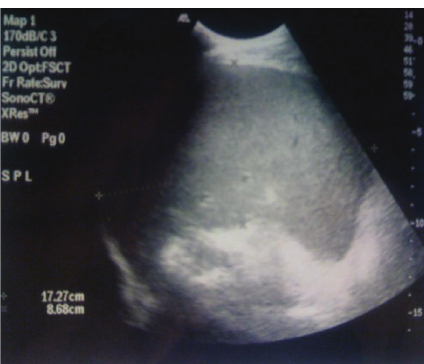
Figure 1: Abdominal ultrasound showed splenomegaly (17,27 × 8,7cm) and free fluid in the left iliac fossa.